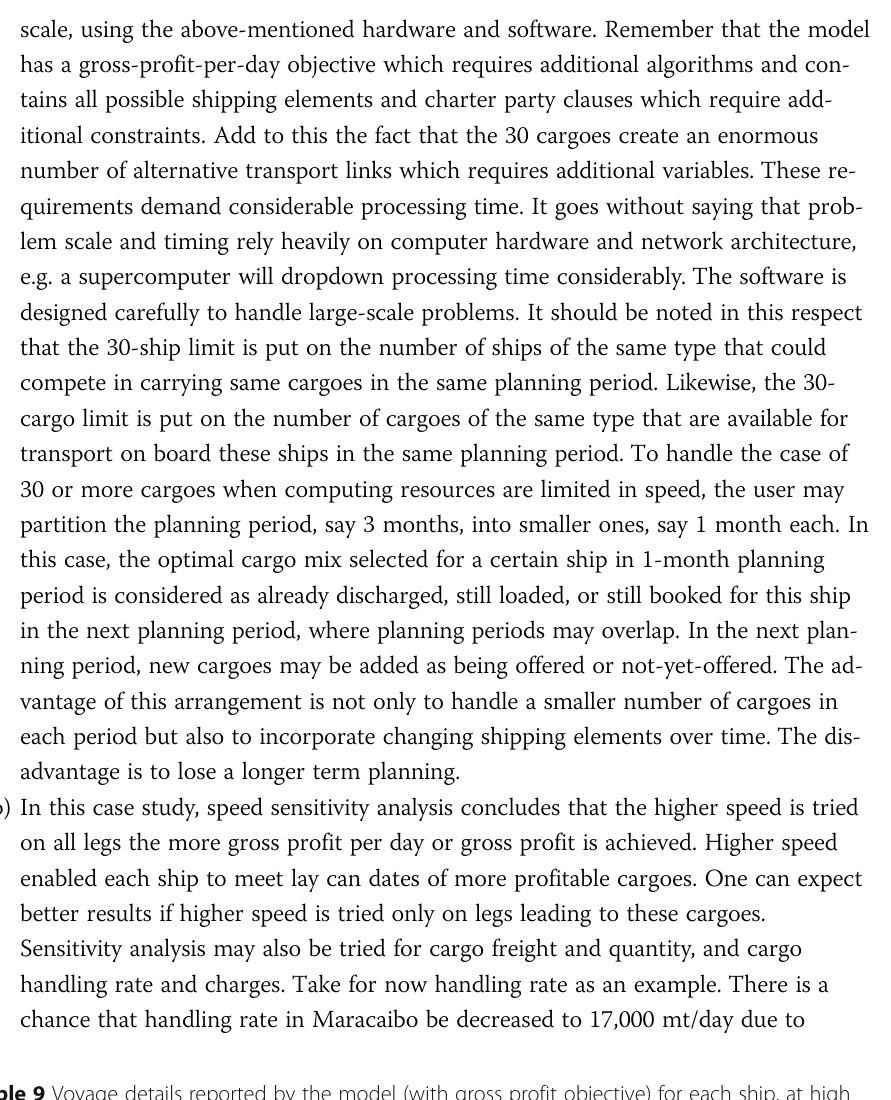
Table 9 Voyage details reported by the model (with gross profit objective) for each ship, at high speed